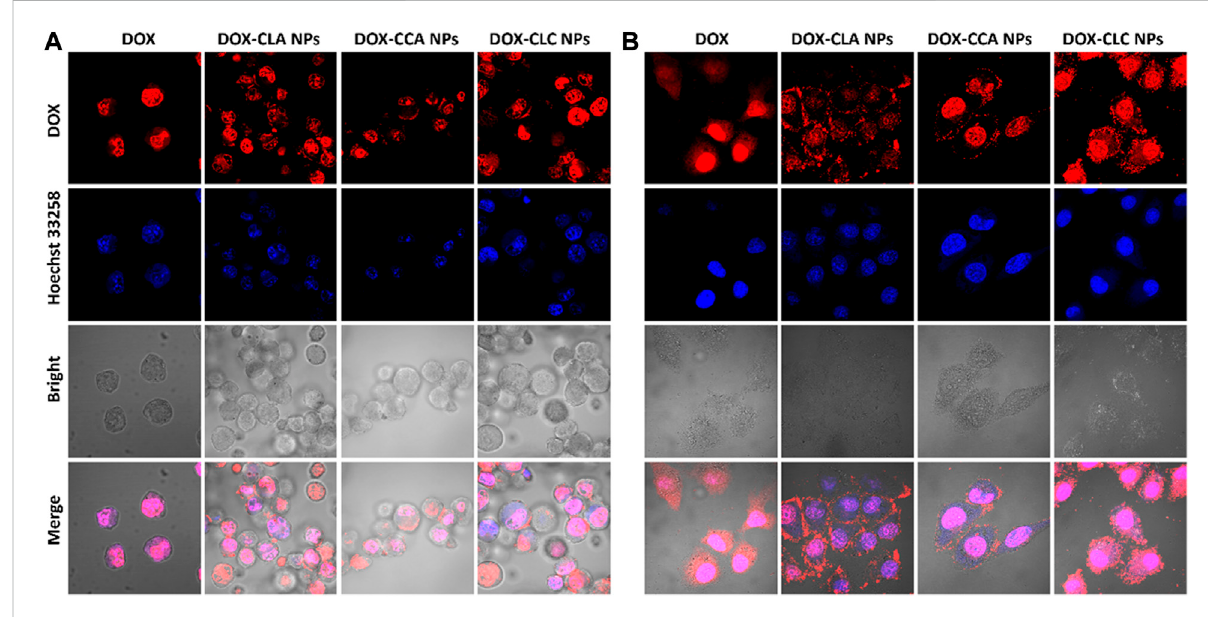
FIGURE 3 Cellular uptake of free DOX, DOX-CLA NPs, DOX-CCA NPs and DOX-CLC NPs after co-cultured with H22 cells (A) and HepG2 cells (B) for 4